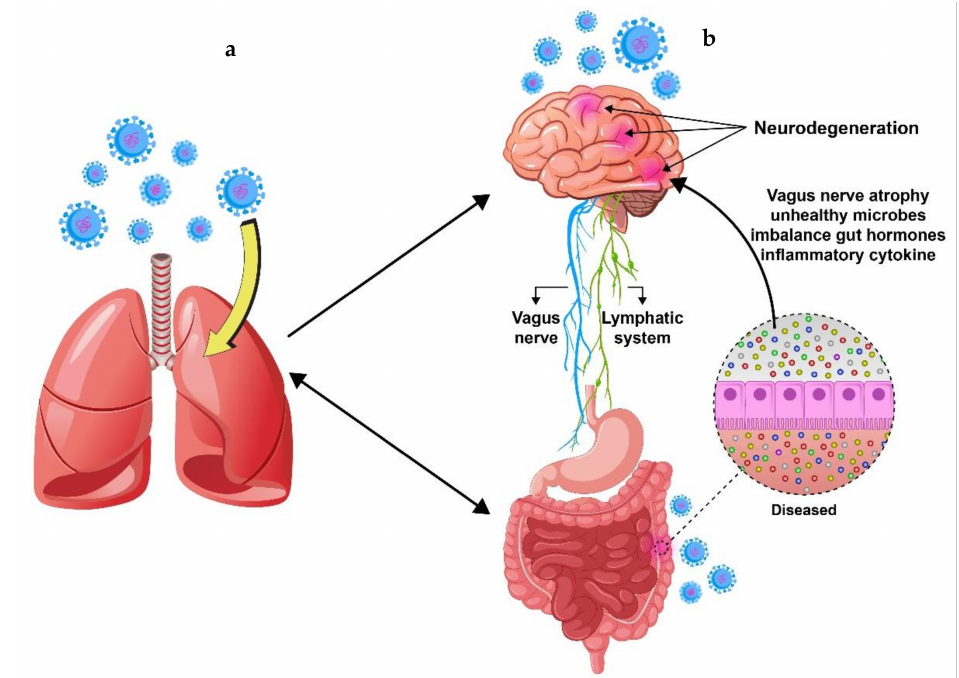
Figure 4. Cross-talk between the lungs ( a ), brain, and gastrointestinal tract ( b ). The metabolites produced by gut microbes not only impact GI immunity but also affect distal organs such as the lungs and brain. The gut and lungs are intricately linked organs that influence each others’ homeostasis through bi-directional cross-talk (termed the gut–lung axis). SARS-CoV-2, by altering the lung microbial community, can influence the composition of the gut microbiota. Similarly, when the composition and diversity of the gut microbiota are changed, the gut microbiota can regulate the lung immune function through the lymphatic or circulatory systems. Additionally, alterations in the intestinal microbiota can lead to CNS disorders via interactions through the gut–brain